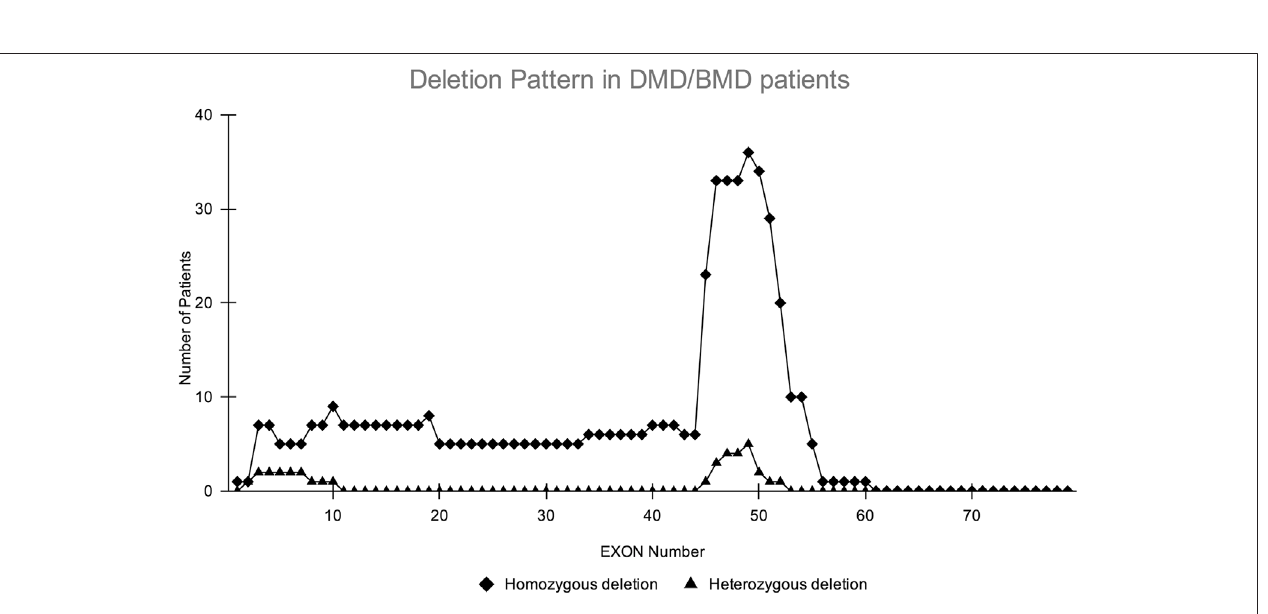
Frontiers in Genetics |